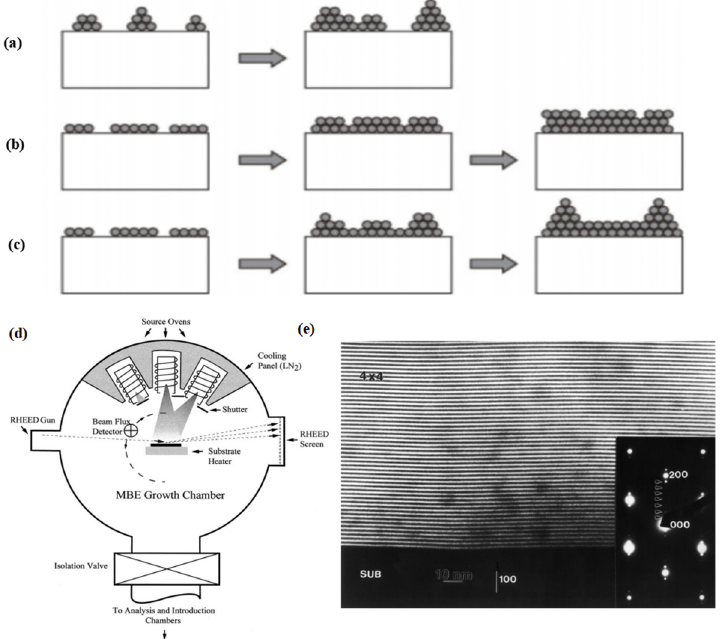
Figure 3. ( a – c ) Three main modes of film growth. ( a ) Frank van der Merve mode. ( b ) Volmer–Weber mode. ( c ) Stranski–Krastanow mode. ( d ) Top view of a simple MBE chamber showing the essential growth sources, shutters, beam flux detector, and the RHEED system for monitoring structure during growth [32]. Copyright 2002, Surface Science . ( e ) Scanning electron micrograph of the cross-sectional view of alternating layers of GaAs (dark lines) and Al x Ga 1 − x As (light lines) grown by MBE